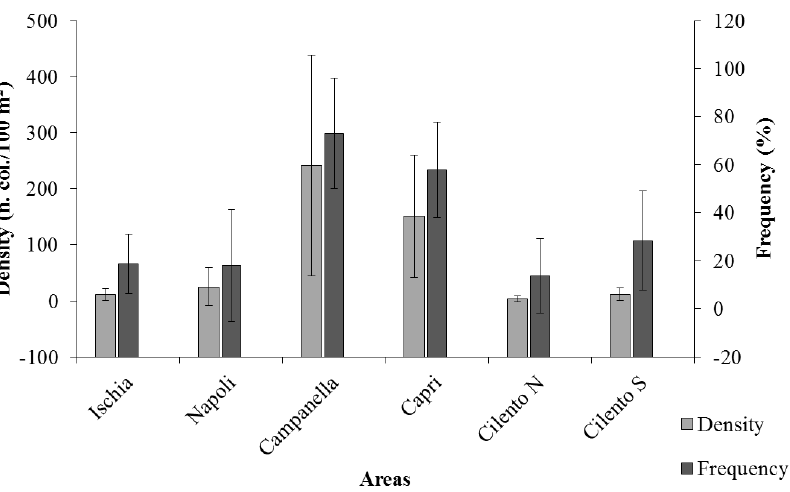
Figure 2. Average values of density (n. col./100 m 2 ) and frequency (%) of coralligenous structuring species (CSS) in each investigated area. Bars represent SD. Table 2. Pairwise tests among investigated areas for CSS densities. The significant p -values are shown in bold.